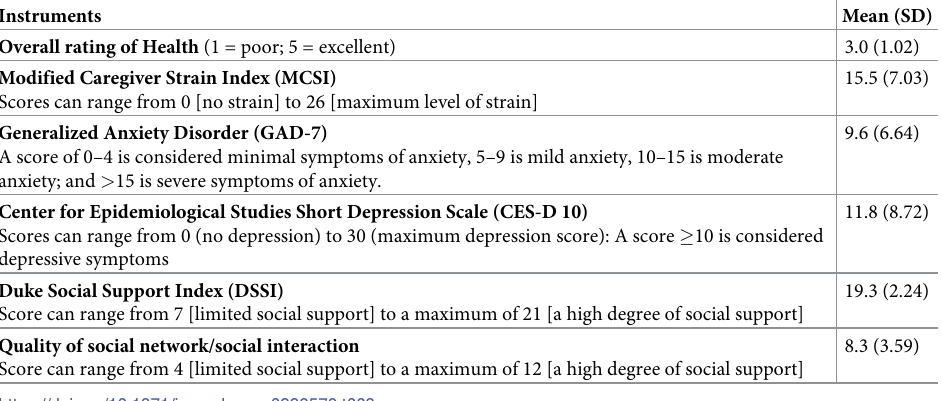
Table 3. Mean scores and standard deviation of instruments measuring caregiver health.